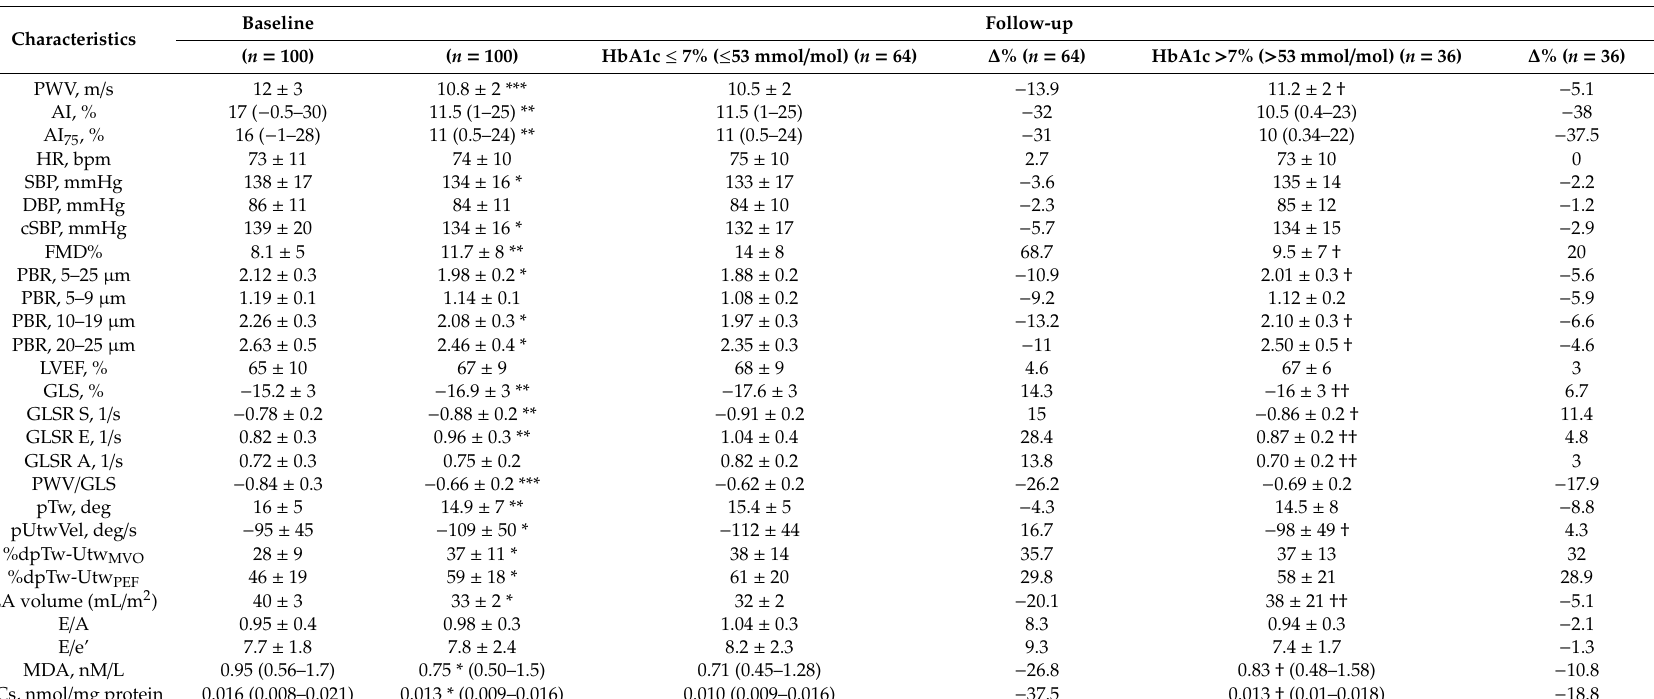
Table 2. Baseline and follow-up values of metabolic characteristics, arterial sti ff ness, endothelial function, LV function, and oxidative